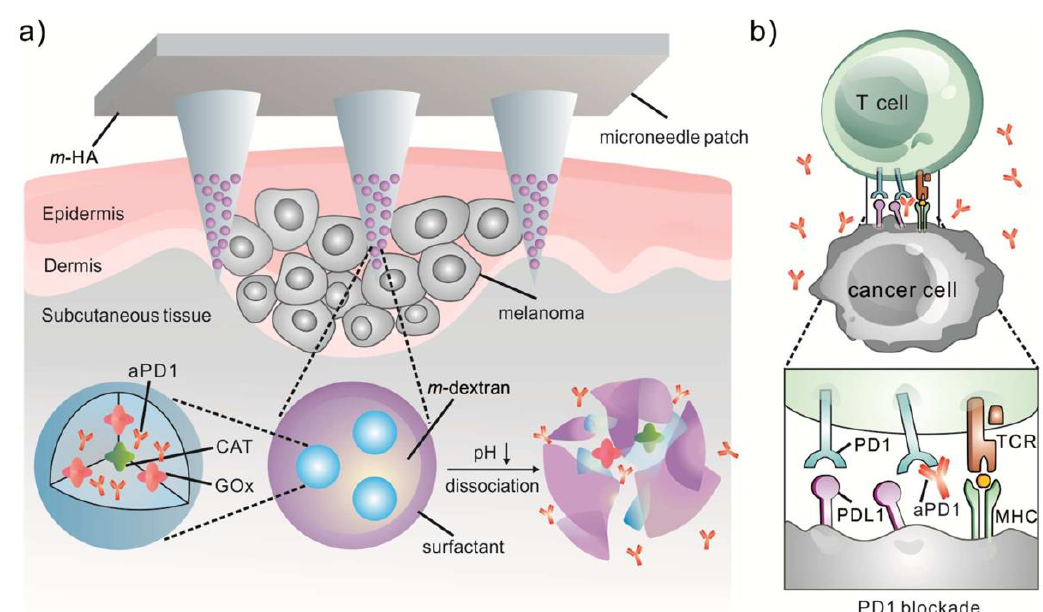
Figure 4. Schematic preparation of the aPD1 containing hyaluronic acid microneedles (HA MNs) for the prevention of skin cancer: ( a ) MNs containing the pH-sensitive dextran nanoparticles encapsulating catalase/glucose oxidase (CAT/GOx) enzyme system that convert the blood glucose to gluconic acid and leading to aPD1 sustained release; ( b ) aPD1 released from the MNs blocks the PD-1 receptor, which resulted in activating the immune cells to kill skin cancer cells; CAT and GOx stand for the catalase and glucose oxidase, respectively. Reprinted with permission from [45] .